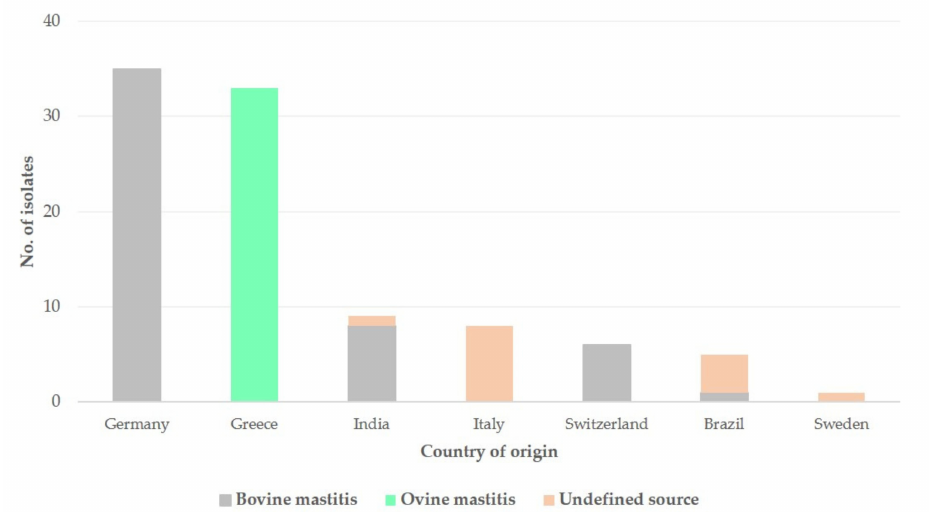
Figure 3. Histogram of the frequency of S. epidermidis isolates from cases of mastitis in the MLST database ( n = 97) according to the country of origin and the source (cattle, sheep). MLST: multi-locus sequence typing.